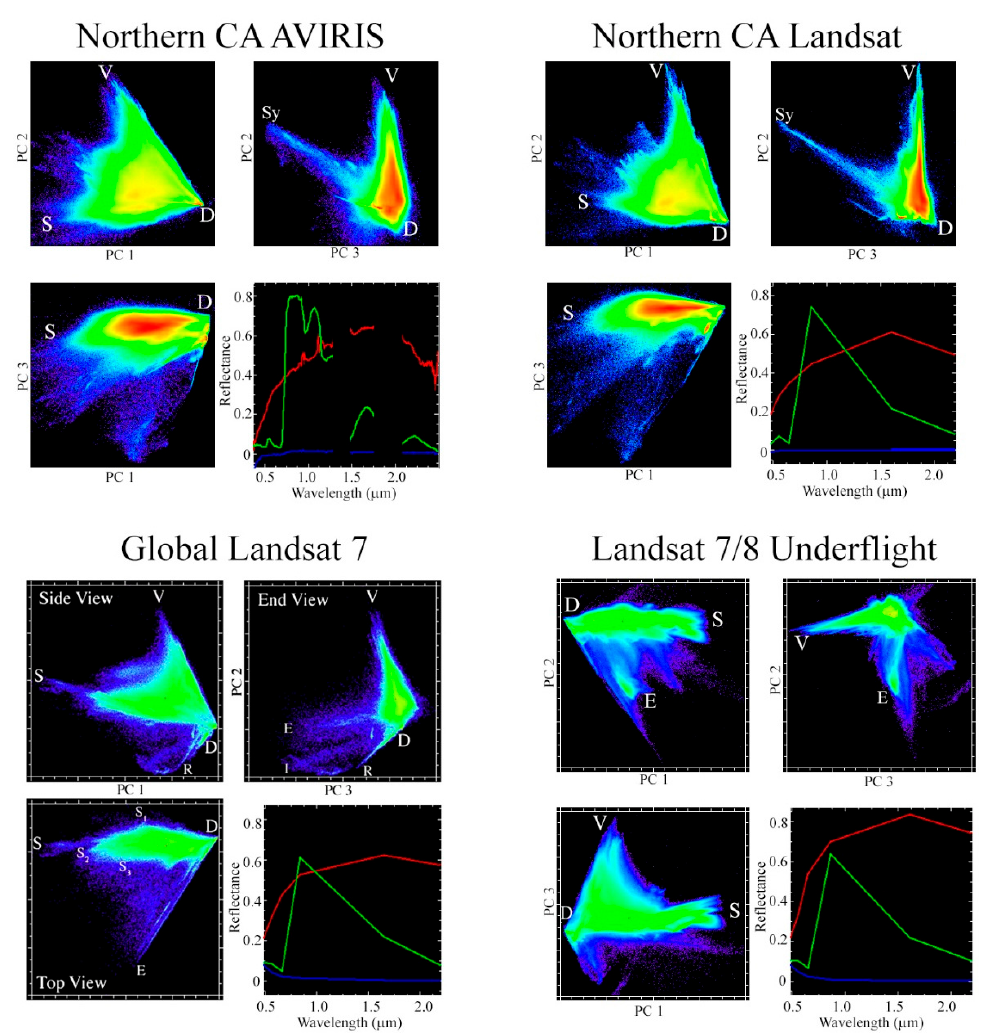
Figure 5. Low dimensional feature space comparison. Northern CA AVIRIS and Landsat used in this study both show similar low-order feature space topology to the much wider range of land covers sampled in the global Landsat 7 analysis of Small & Milesi (2013), as well as the Landsat 7/8 underflight comparison analysis of Sousa & Small (2017). Substrate (S), Vegetation (V), and Dark (D) EMs are also broadly consistent across all four studies, in spite of the substantial disparities in both spectral resolution and spatial extent. Differences in topology are predominantly due to variations in sampling of relatively rare land covers such as evaporites (E) and synthetic materials (Sy). Substrate EMs show the greatest variability, as expected given the diversity in the shape of the reflectance continuum of rock and soil.